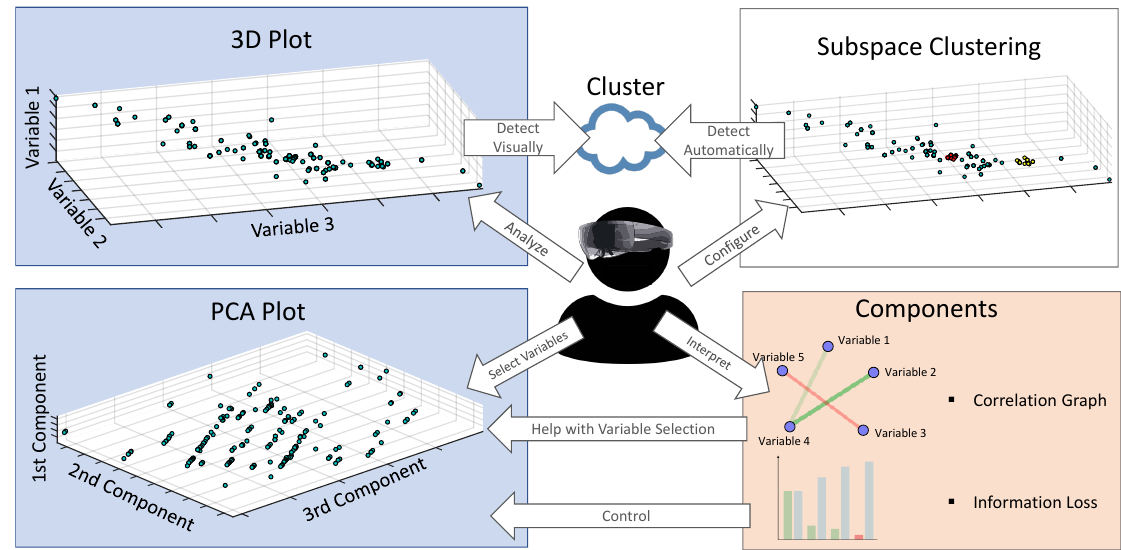
Figure 4. Proposed Approach at a Glance. The 3D plot ( top left ) can be used to display variables and detect clusters. A subspace clustering algorithm ( top right ) reveals automatically detected clusters. With the use of the PCA plot ( bottom left ) and additional components ( bottom right ), dimensionality reduction can be applied and